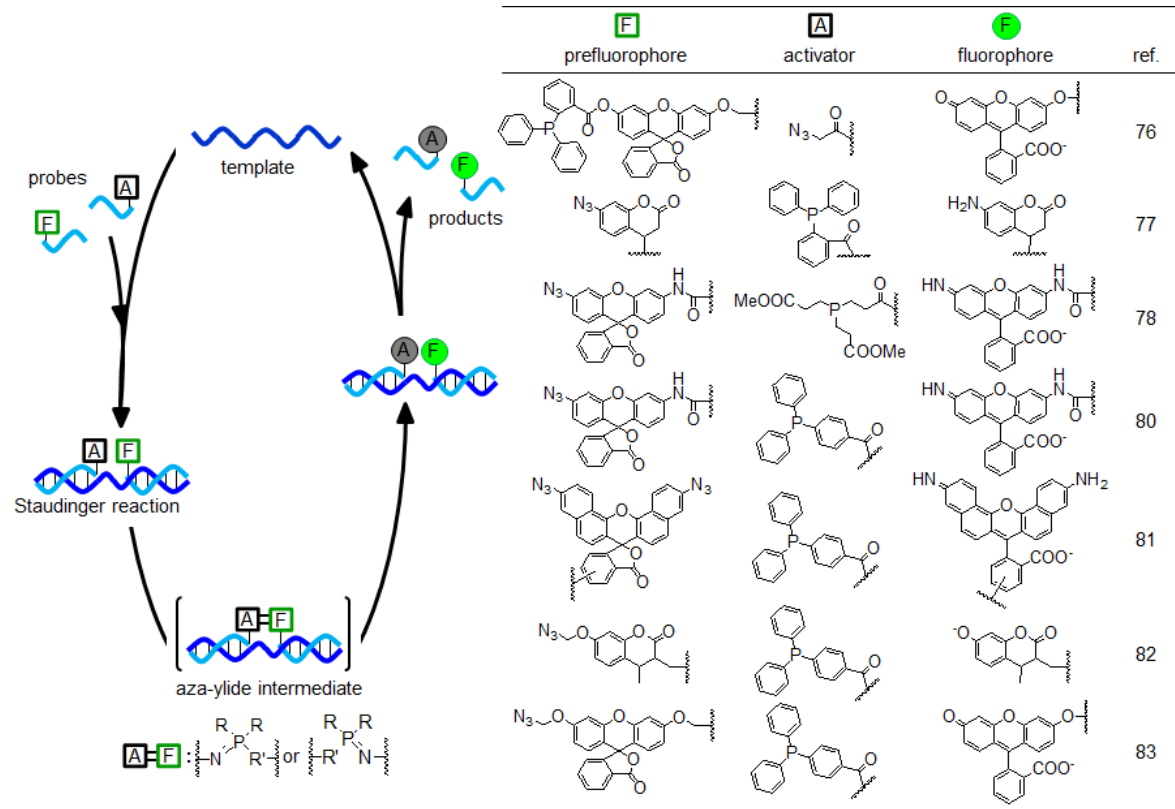
Figure 6. Fluorescence signal-generating method triggered by the Staudinger